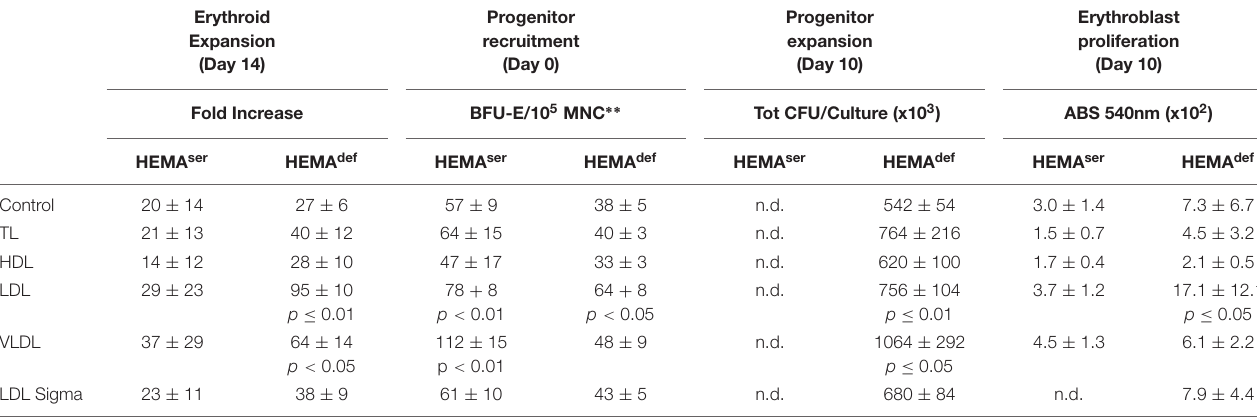
TABLE 3 | Summary of the effects induced by the various lipoprotein fractions on the end-points used to assess the efficiency of erythroid